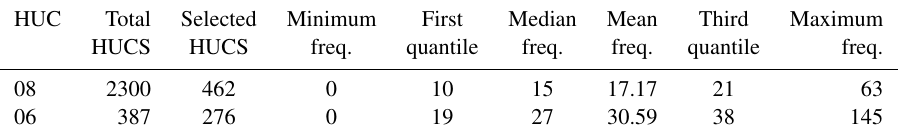
Table B1. HUC8 and HUC6 frequency summary statistics.